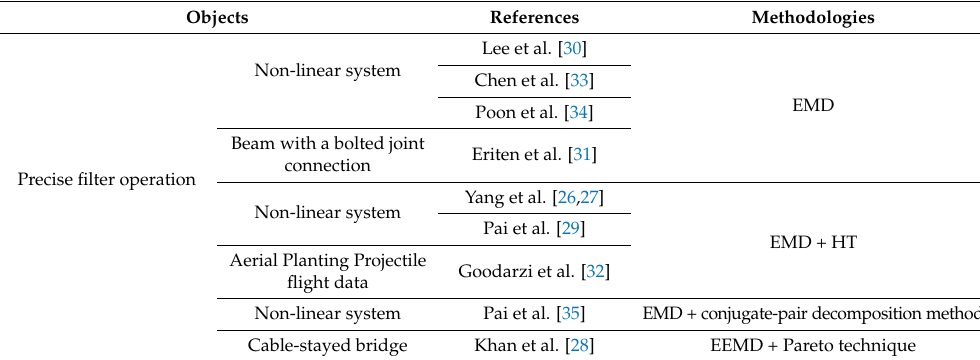
Table 1. Summary of works for